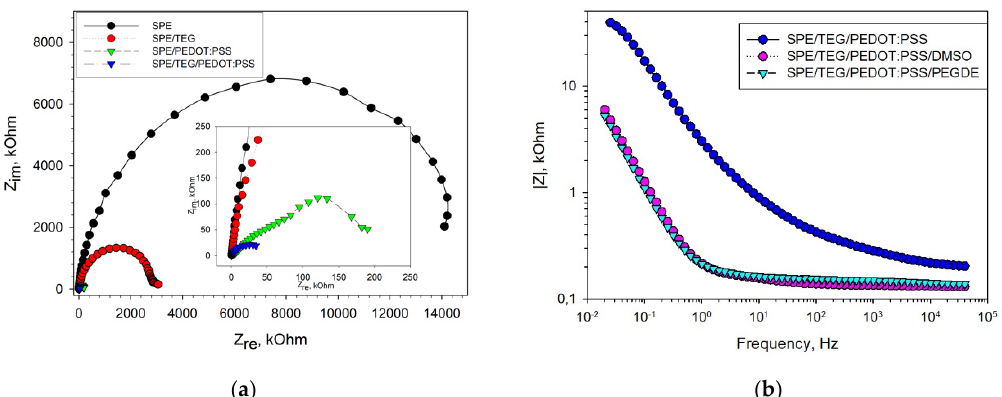
Figure 2. EIS Nyquist plots recorded in the presence of a 5 mM [Fe(CN) 6 ] 3 − / 4 − redox couple prepared in a 25 mM phosphate buffer with 0.01 M NaCl at an open-circuit potential (+200 mV vs. Ag/AgCl). ( a ) Change in impedance due to the presence of TEG, PEDOT:PSS and TEG/PEDOT:PSS on SPE; ( b ) change in the impedance profile due to a modification of PEDOT:PSS with DMSO and PEDOT:PSS with DMSO and PEGDE.